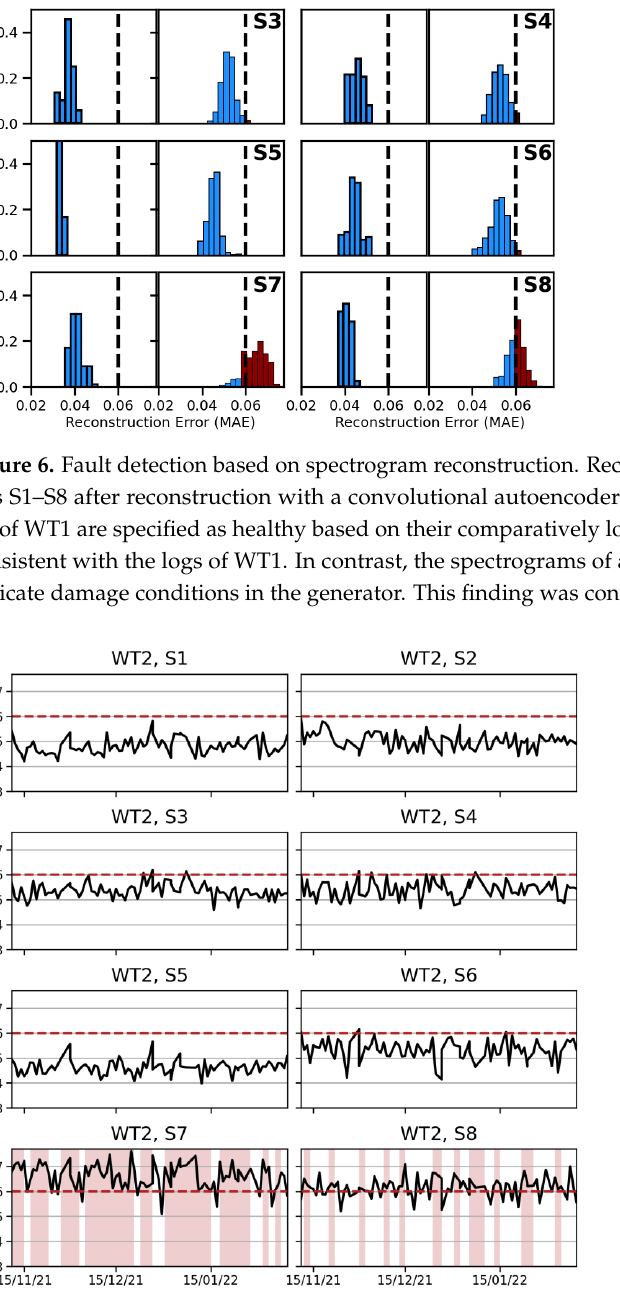
Figure 7. Fault detection based on spectrogram reconstruction. The reconstruction errors are considered health indices of the monitored drivetrain components of WT2. The red dashed line represents our threshold, set at 0.06, the maximal reconstruction error before a segment is classified as anomalous. Red shaded areas represent periods when the alarm notification criterion is active, following three consecutive crossings of the threshold.